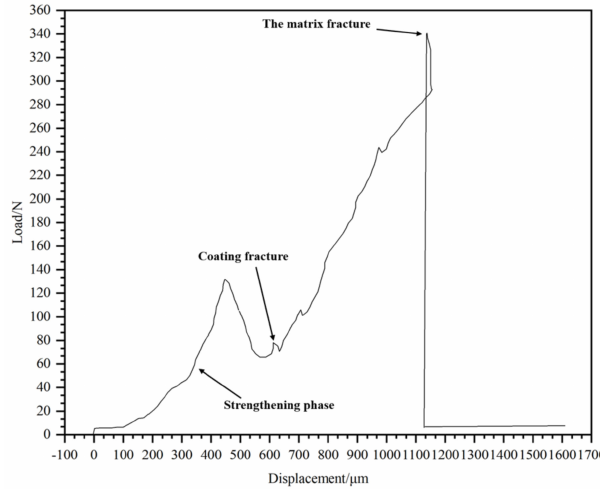
Figure 5. Loading curve of a coated specimen at 766 ◦ C.